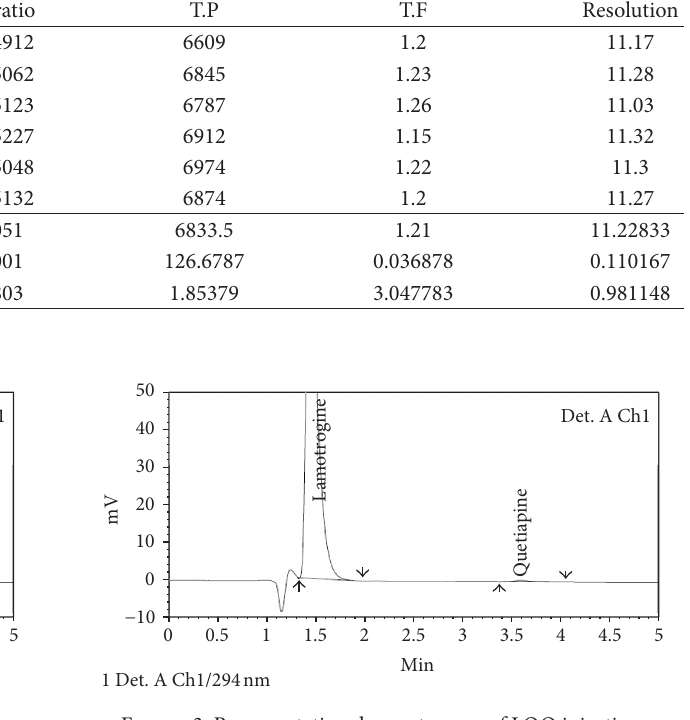
F 2: Representative chromatogram of LOD injection. F 3: Representative chromatogram of LOQ injection.